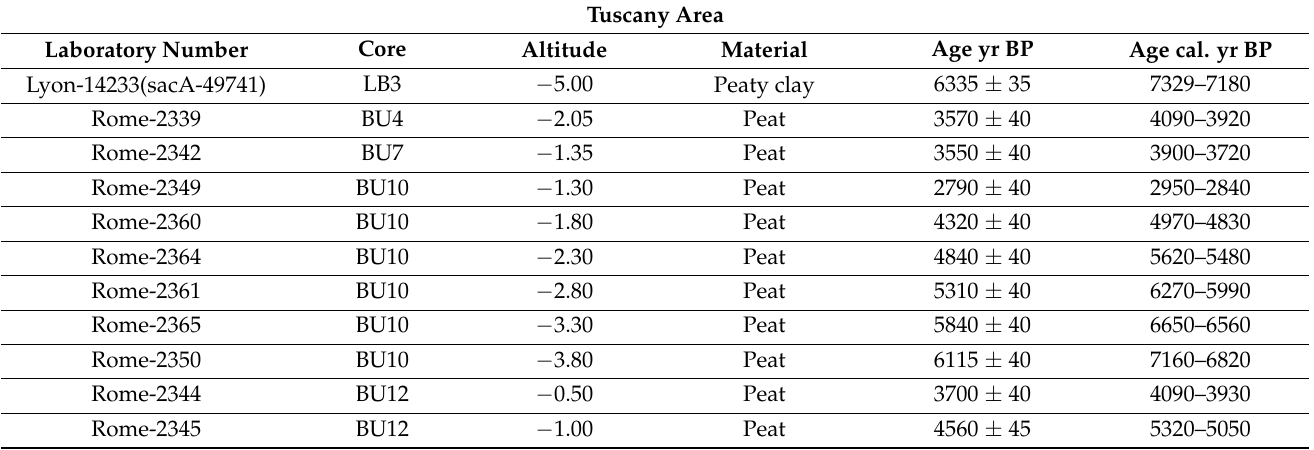
Table 1. The values of the 14 C ages used to plot the sea level rise curves of Figures 4, 8 and 11 are reported. Tuscany